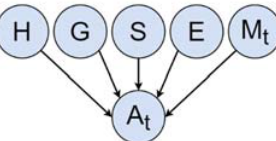
Figure 3. A Bayesian network with the five variables that influence the next assembly step.